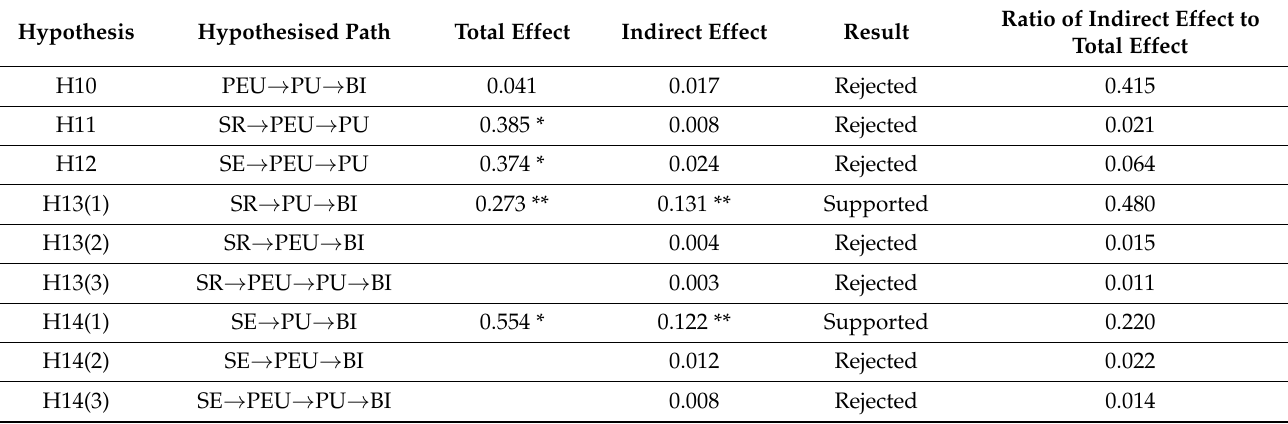
Table 6. Total and indirect effects and ratio of